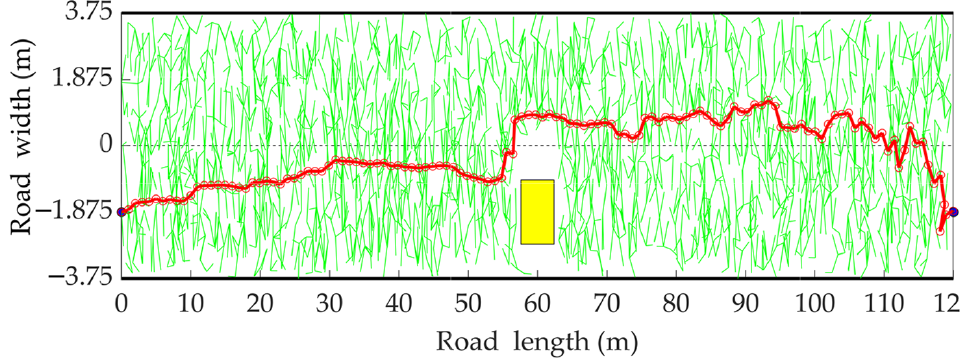
Figure 4. Performance of the basic RRT for a straight road.